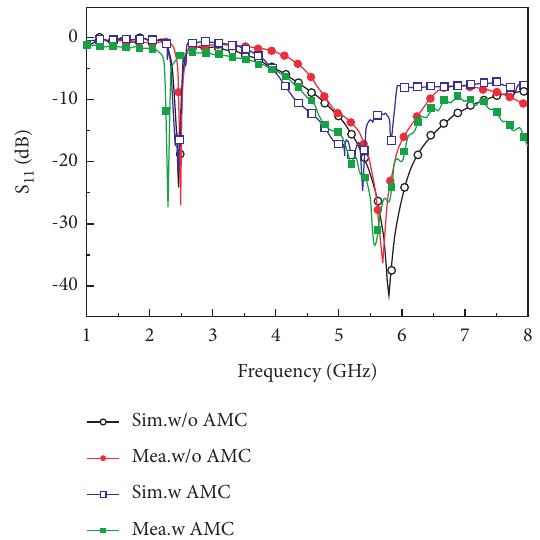
Figure 5: Simulated and measured S antenna with and without AMC.